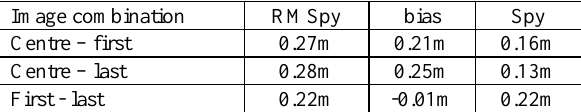
Table 4: y-parallaxes of intersection based on least squares matching